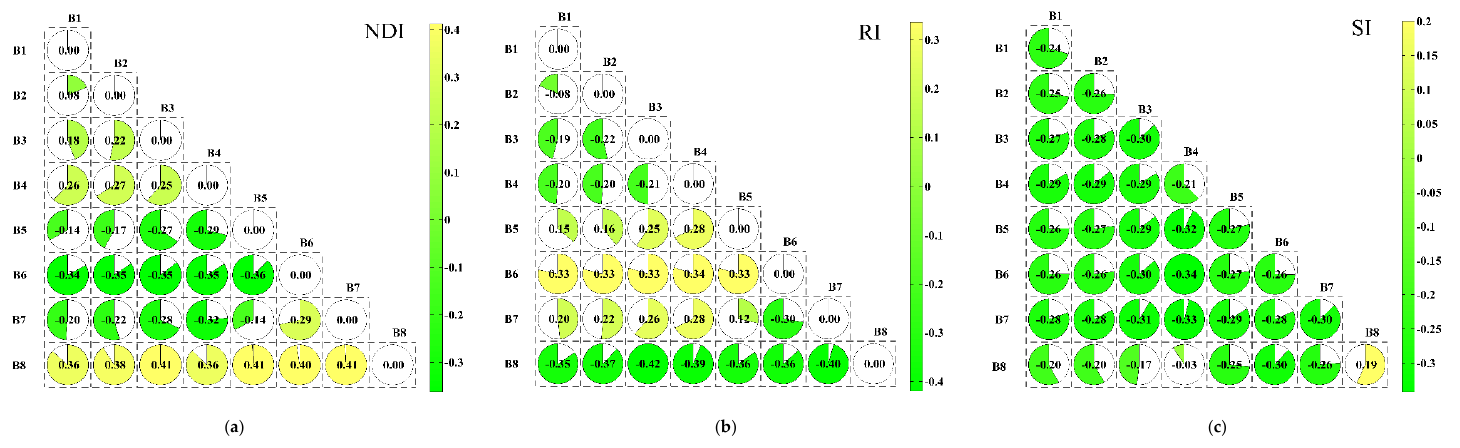
Figure 10. The correlation analysis between EC and optimized spectral indices based on reciprocal first derivative (1 / R-FD). ( a – c ) represent the correlation EC with NDI, RI, and SI,